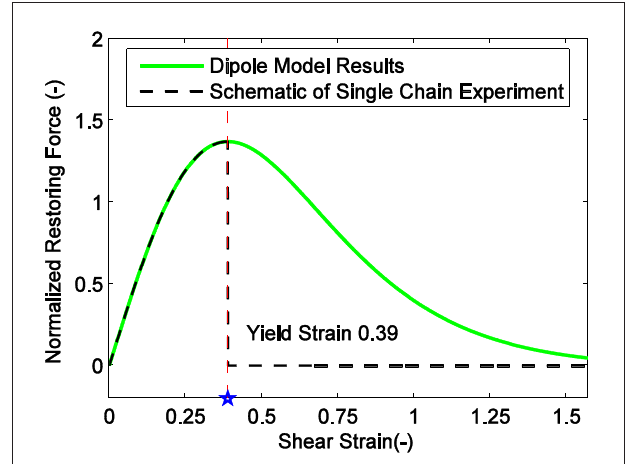
FIGURE 5 | Schematic of the deformation of a single chain of MR fluids in shear mode under magnetic field.